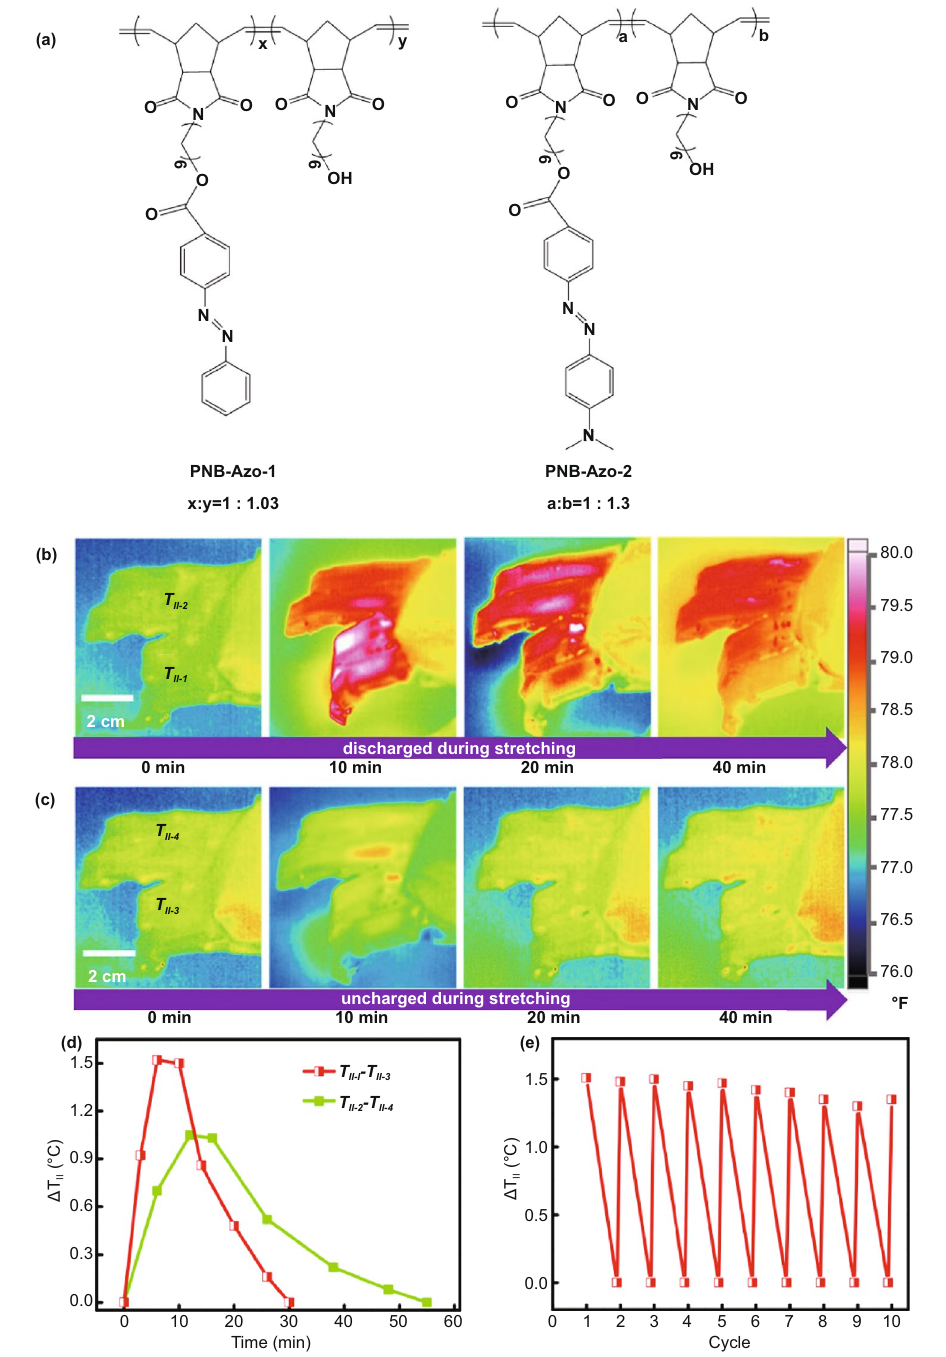
Fig. 21 a Chemical structure of PNB-Azo-1 and PNB-Azo-2. b IR thermal images of charged four fingers (two fingers bend reversibly, II-1 and the other stay II-2). c IR thermal images of uncharged four fingers (two fingers bend reversibly, II-3 and the other stay II-4); d Δ TII at different times and e its change in 10 cycles. The temperature is obtained by averaging the data at 4 time points